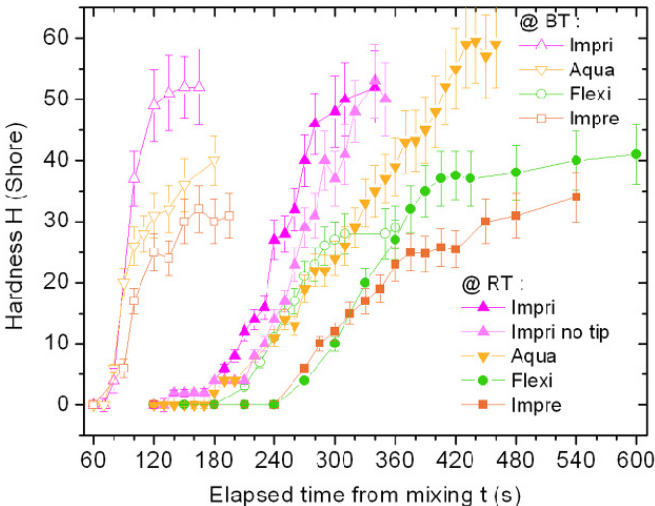
Figure 3. Shore hardness measurements for the four materials made at RT (filled symbols) and BT (void